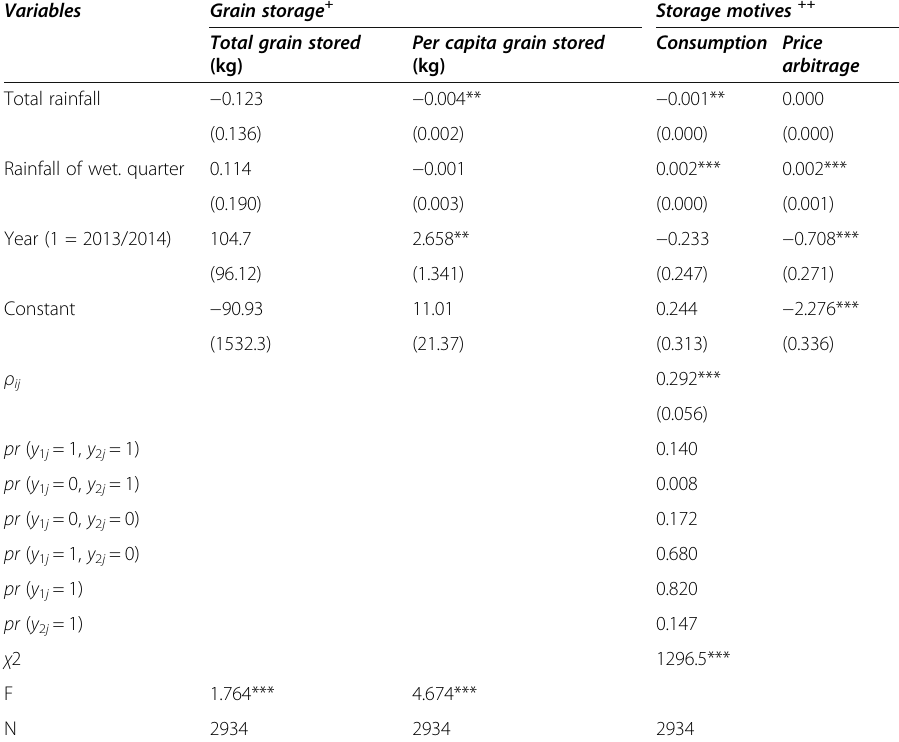
Table 4 Determinants of maize storage and storage motives (Continued) Variables Grain storage + Storage motives